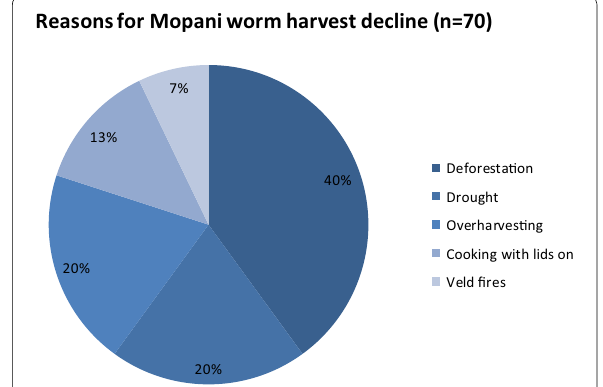
Fig. 6 Reasons for the Mopani harvest trends